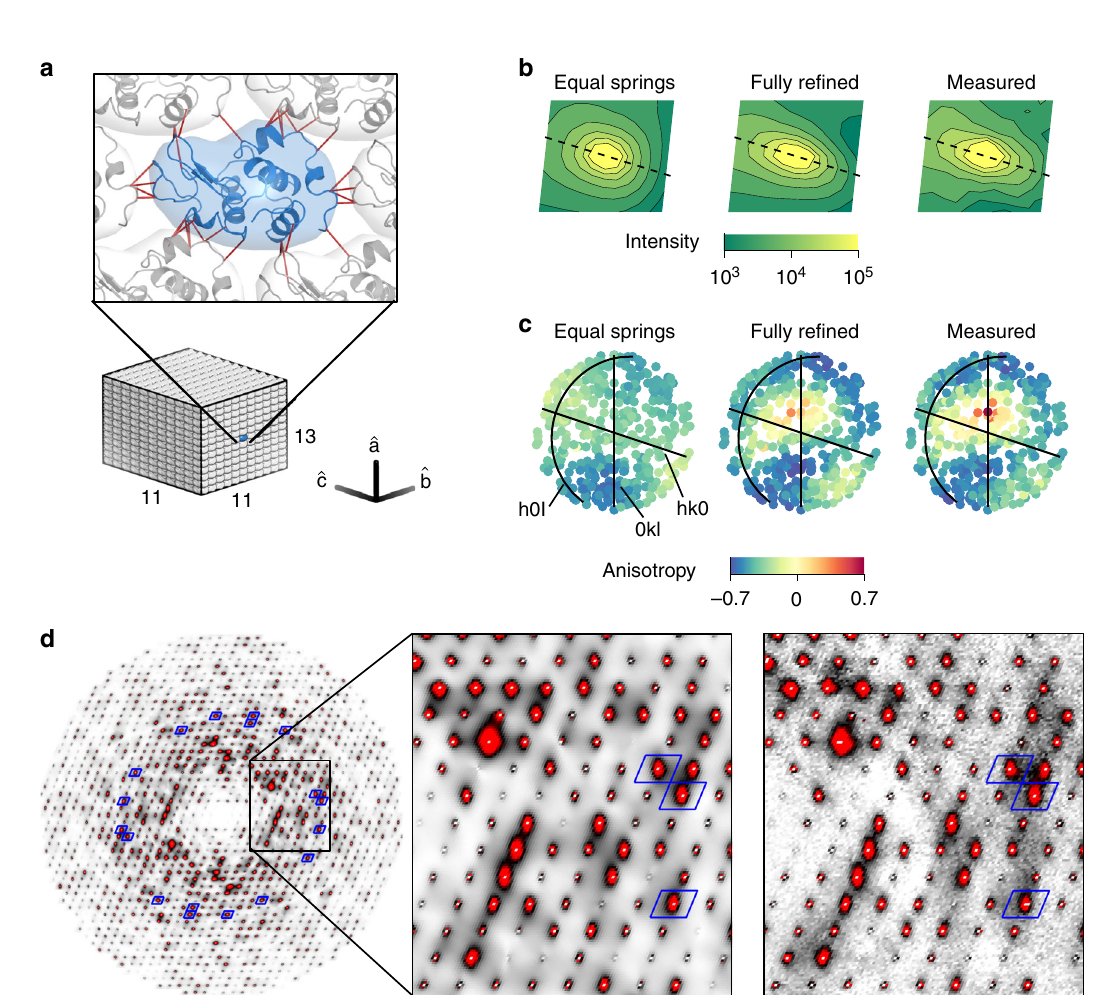
Fig. 3 Lattice dynamics model re fi ned to diffuse scattering. a A lattice dynamics model was constructed with rigid protein units arranged in a 13 × 11 × 11 supercell with a linear combination of Gaussian and directional springs connecting the C α atoms of residues involved in lattice contacts (dark red lines). Spring constants were re fi ned to fi t the variational scattering around 400 intense Bragg peaks between 2 and 2.5 Å resolution. b Comparison of predicted and measured halo intensity around the (1,2,13) Bragg re fl ection in the h = 1 plane. The plane perpendicular to the scattering vector is indicated by a dashed line. The model with equal Gaussian springs does not reproduce this shape as well as the fully-re fi ned model. c The shape anisotropy of each of the 400 halos used for model fi tting was quanti fi ed and mapped as an equal-area projection of the hemisphere centered on b *. Full re fi nement of the spring constants was needed to reproduce the pattern of halo anisotropy seen in experiment. d The simulated one-phonon scattering for the fully-re fi ned lattice model (left) is compared with the measured variational scattering (right) in the l = 0 plane. The intensity scale is the same as Fig. 1c. Blue boxes surround halos that were included in the fi neighboring molecules via spring-like interactions (detailed in potential to be a linear combination of two types of springs: Methods). The proteins were arranged in a 13 × 11 × 11 supercell to Gaussian and directional. Gaussian springs 37 have a restoring force that is independent of the direction of the displacement relative to match the sampling of the experimental map (Fig. 3a). Residues of the spring, and directional springs 38 have a restoring force only neighboring molecules that form lattice contacts were linked by a along the vector between the end-points. pair potential between alpha carbons (Fig. 3a, dark red lines), The model was re fi ned against a set of 400 intense halos between re fl ecting a restoring force that depends on the relative displace- 2 and 2.5 Å resolution, consisting of a total of ~600,000 voxels. As ments of the two end-points. For generality, we allowed each pair